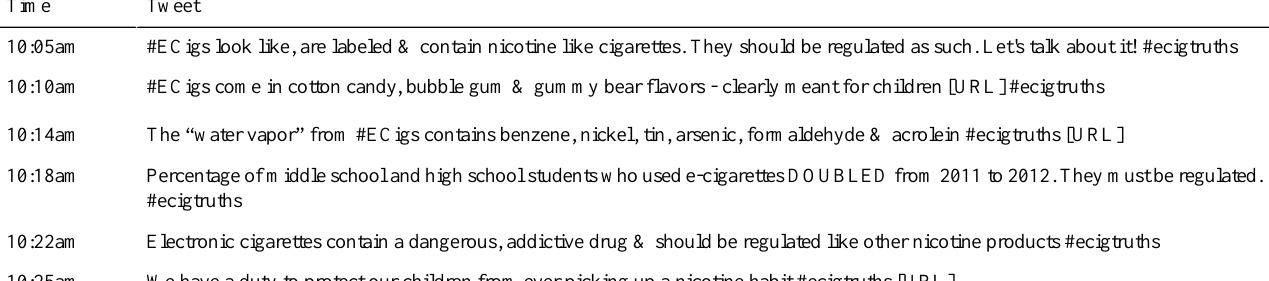
Table 1. E-cigarette tweets sent by the Chicago Department of Public Health (@ChiPublicHealth) on January 8, 2014 a .